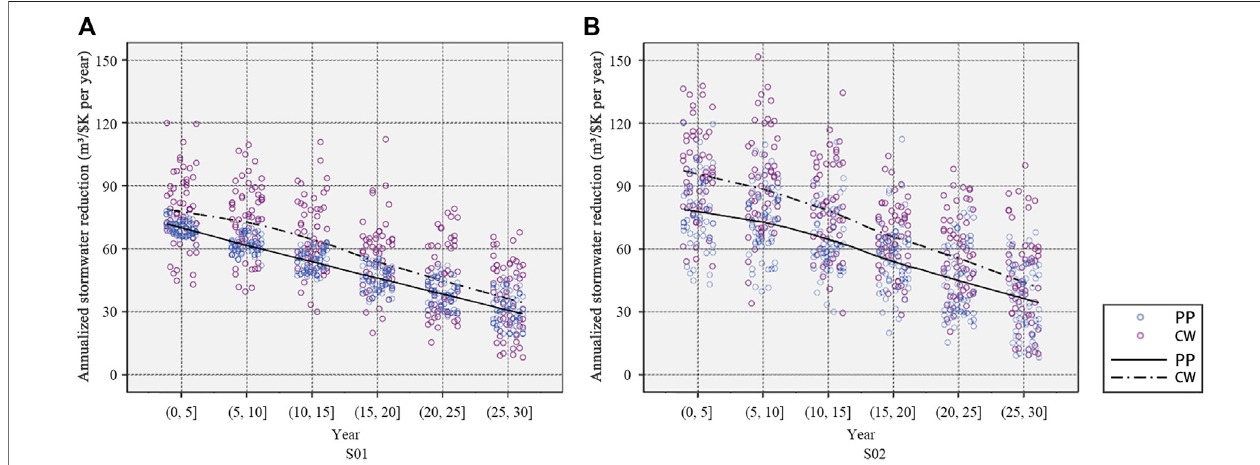
FIGURE 5 | Annualized stormwater reduction of LIDs in (A) S01 and (B) S02 based on the long-term effectiveness analysis in a simulated period.